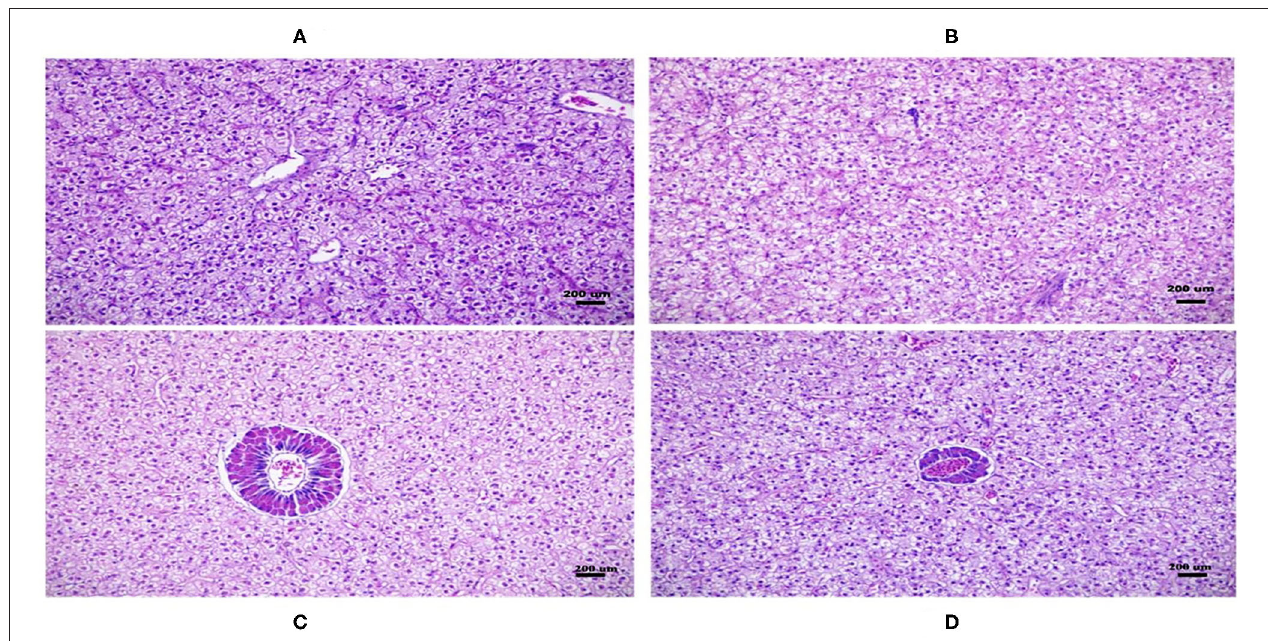
FIGURE 1 | Hepatopancreatic cross-sections of the fish from the native and imported dried distillers grains with solubles (DDGS) groups stained with hematoxylin–eosin (H&E) (200 × ). Hepatopancreatic histology of native DDGS20 and DDGS30 (A,B) as well as imported DDGS20 and DDGS30 (C,D) groups showed normal hepatocyte without obvious swelling or